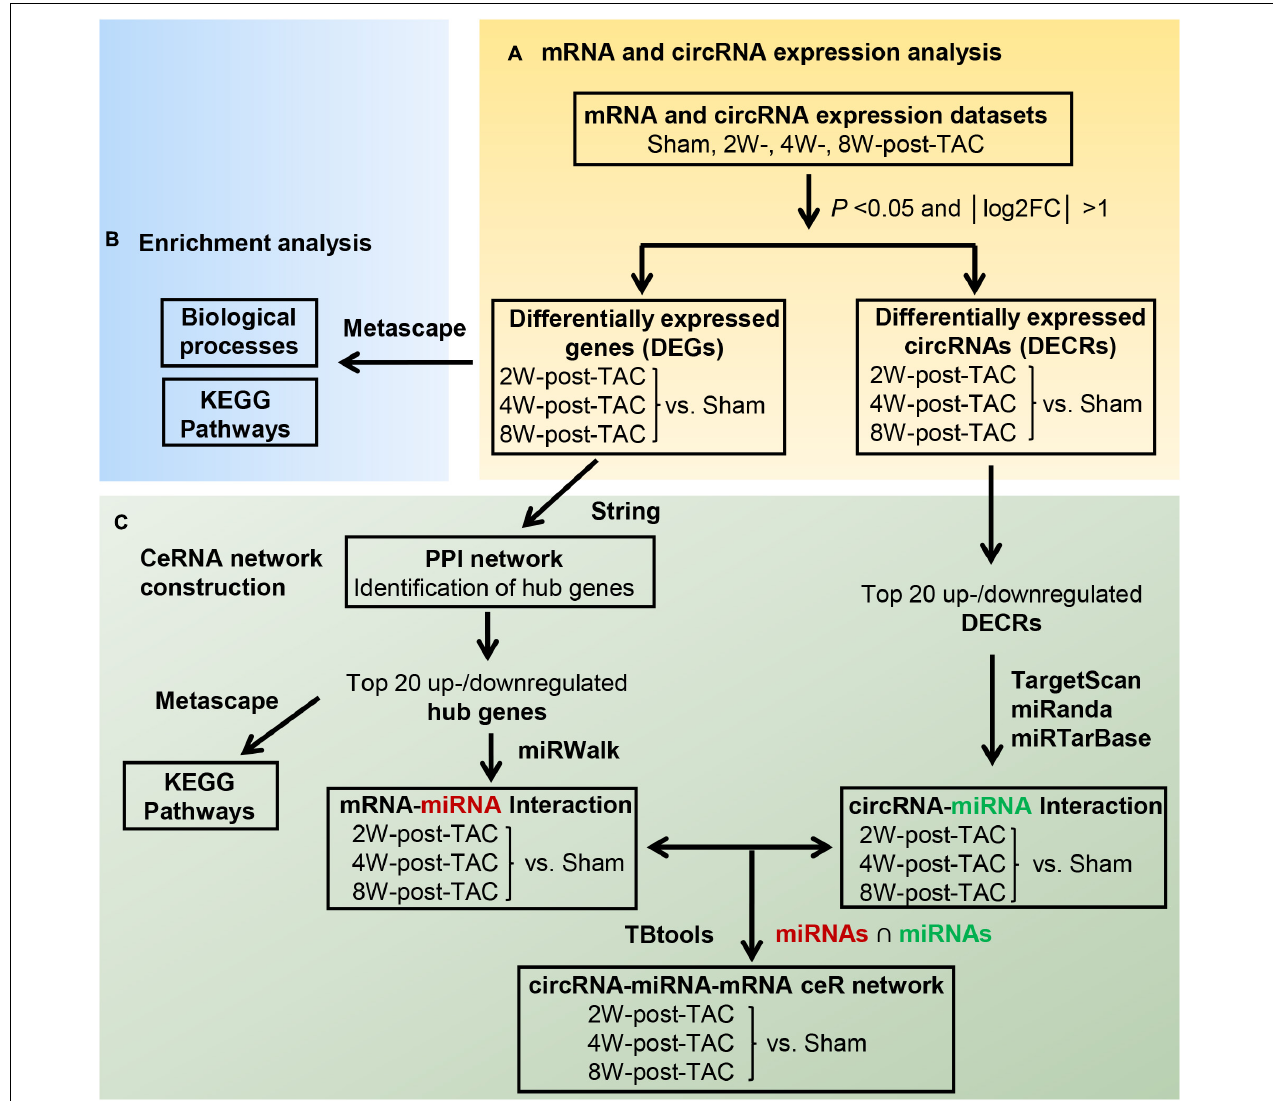
FIGURE 5 | Flow diagram of the bioinformatics analyses. The analyses of the differential expression profiles of mRNAs and circRNAs in murine 2W-, 4W-, and 8W-post TAC hearts was shown in panel (A) . After characterizing the mRNA expression profiles, the DEGs were subjected to functional enrichment analysis using Metascape (B) . The ceRNA network construction procedure for 2W-, 4W-, and 8W-post TAC hearts (C) included (1) the top 40 hub genes were identified by PPI network analysis in the three stages of heart failure and hub gene enrichment analysis by Metascape, (2) Top 20 upregulated and 20 downregulated hub genes were proceeded to predict the miRNAs that inhibit the mRNAs of these hub genes. (3) Top 20 upregulated and 20 downregulated DECRs were subjected to predict the miRNAs that bind to circRNAs. (4) The intersection of miRNAs predicted from two interactions of “mRNA-miRNAs” and “circRNA-miRNA” served as an intermediator for the circRNA-based ceRNA regulation on